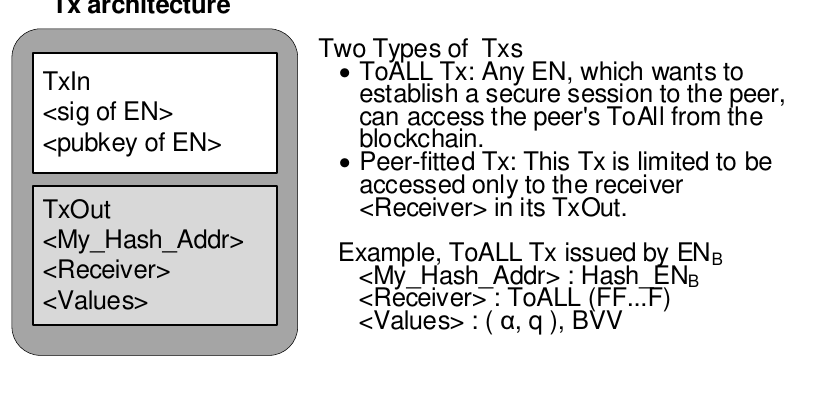
Figure 4. BSM transaction architecture.